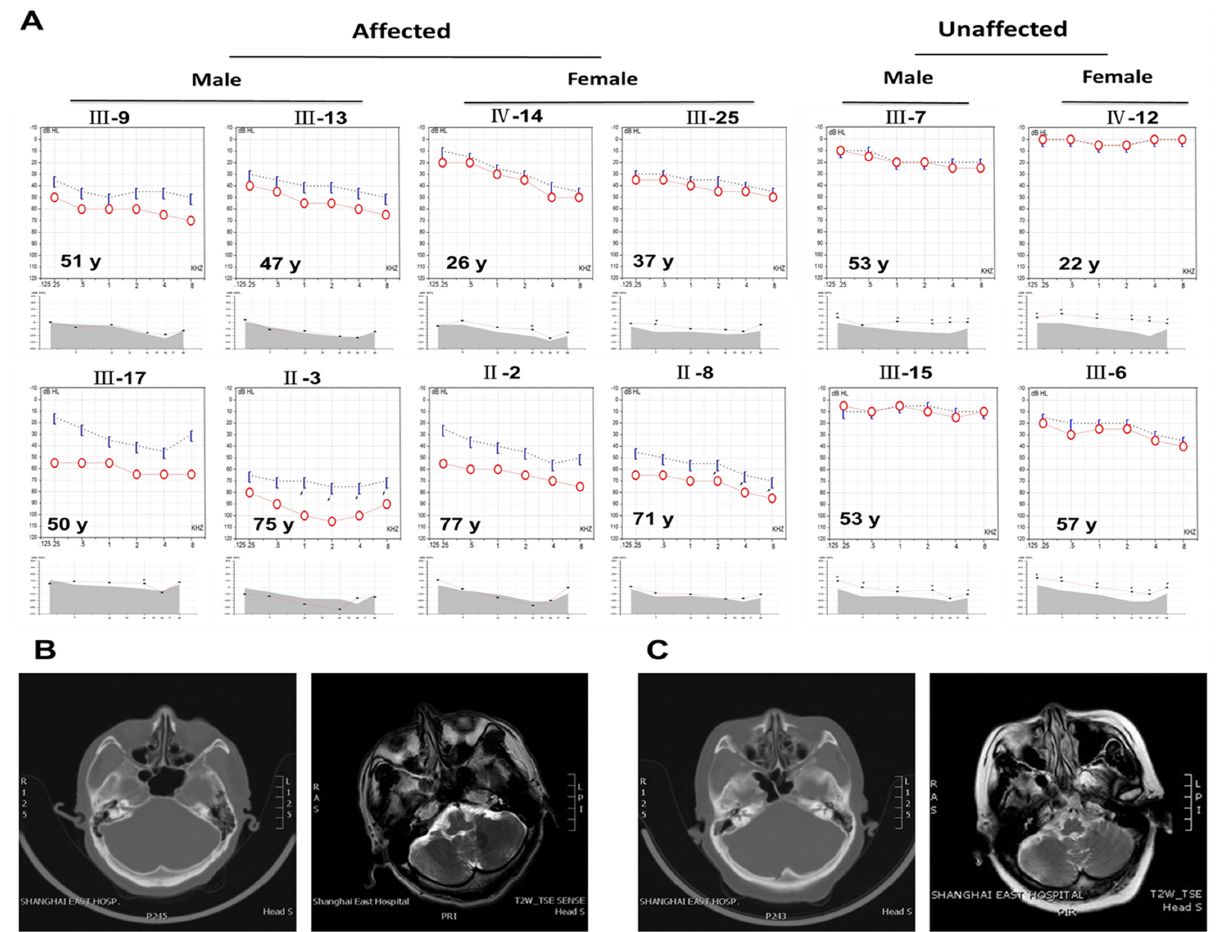
Fig 2. (A) SH-01 audiometric phenotype. Pure-tone bone and air conduction thresholds as well as otoacoustic emission are presented for the right ears of the SH-01 family members. Two representative stages (early and late) are presented, with corresponding audiograms. Blue half-frame and open, red circles indicate the bone and air conduction thresholds, respectively, for the indicated ages, from youngest to oldest. Both conduction thresholds were consistent with predominant SNHL, and some individuals at the later stage displayed conductive hearing loss. In the family, Otoacoustic emission could be induced at most frequencies in individuals with normal hearing, while it was the reverse in affected individuals. (B, C) Based on the CT scan and MRI data of the proband (III9) and his aunt (II2), the mastoid process and cochlea were well developed, and the ossicular chain was intact. Additionally, both the internal auditory meatus and the membranous labyrinth were well